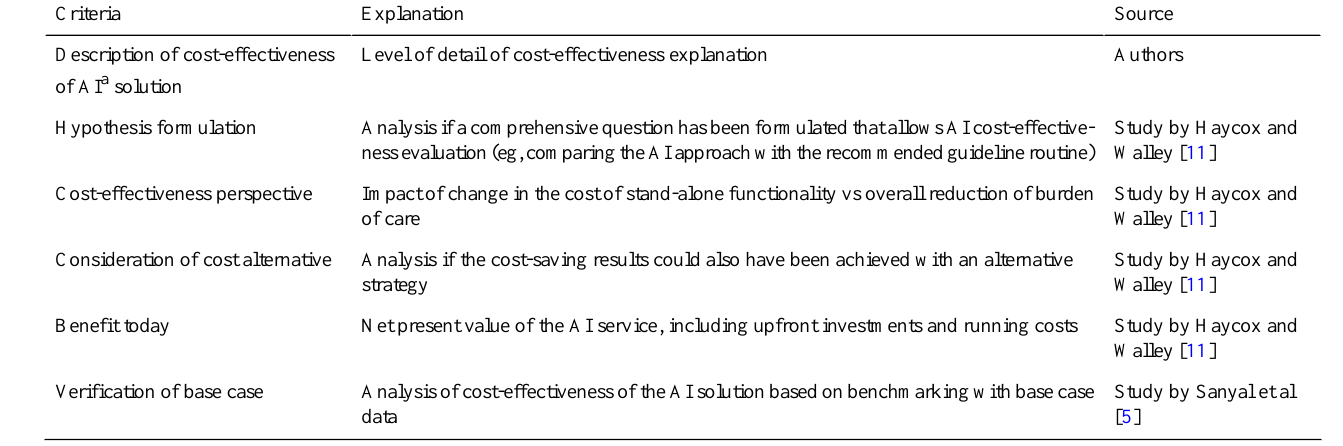
Table 2. Quality criteria for economic impact